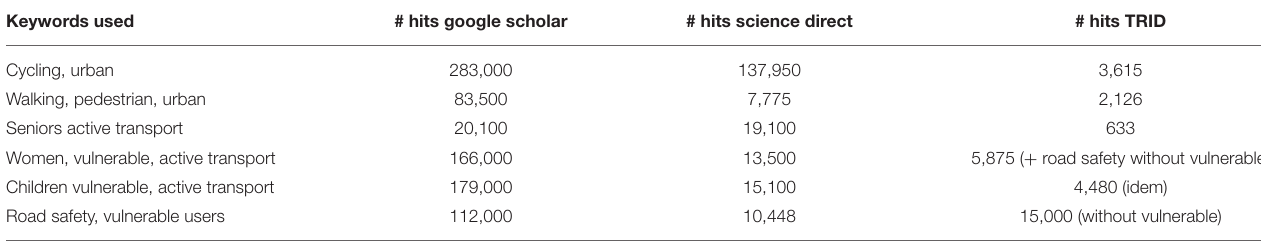
TABLE 1 | Overview of literature-review results